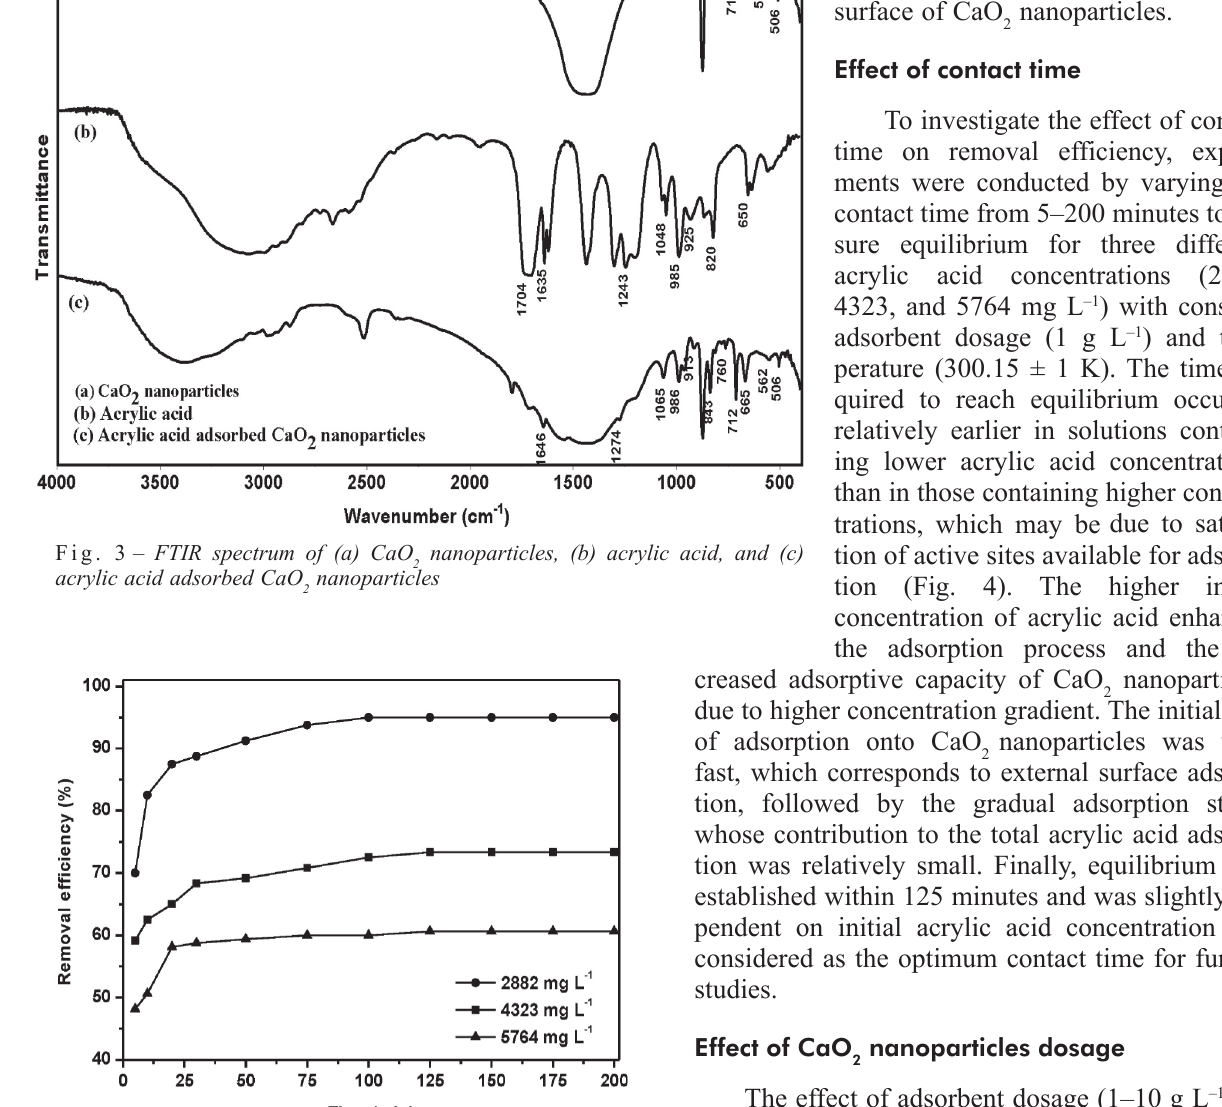
Fig. 4 – Effect of contact time on the removal efficiency of acrylic acid onto CaO nanoparticle (initial acrylic acid concen- 2 tration = 2882, 4323, 5764 mg L –1 , adsorbent dosage = 1 g L –1 , temperature = 300.15